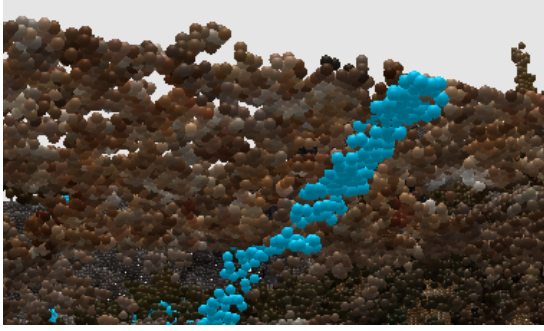
Figure 7: A 6 cm wide strip (profile A) of the UAV-MVS point cloud viewed with the T-MVS point cloud.